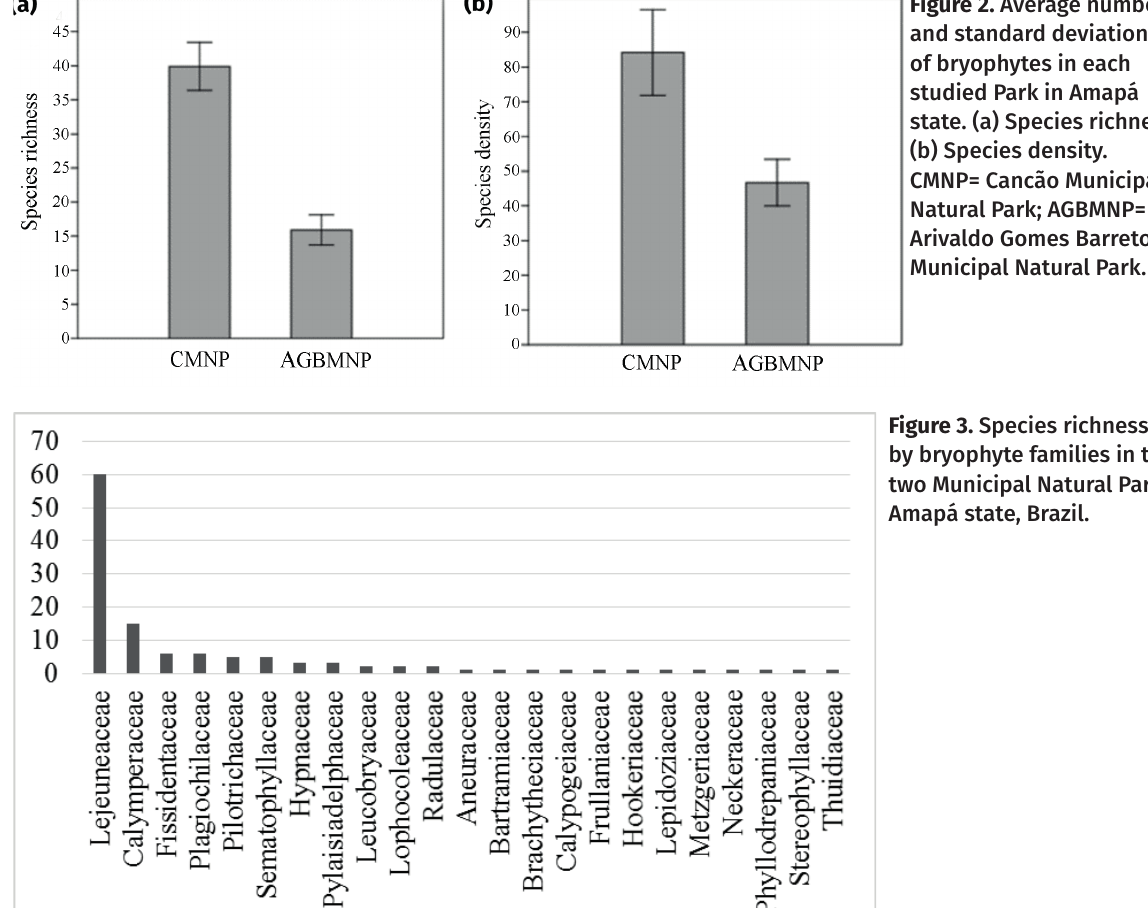
Figure 2. Average number and standard deviation